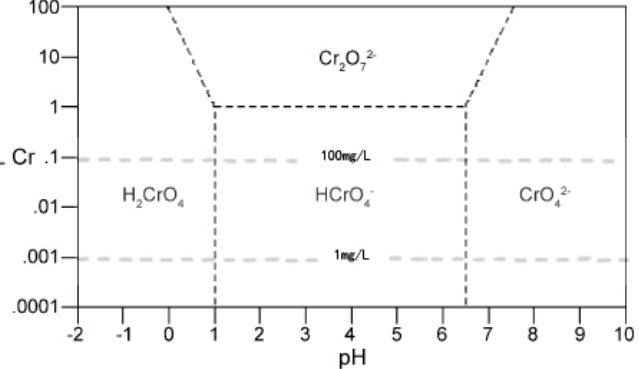
Figure 4. Speciation diagram of Cr(VI) at different pH.